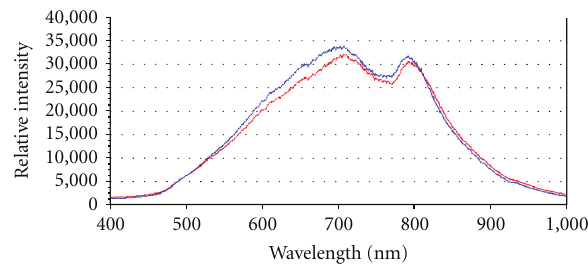
Figure 3: The light scattering curve as demonstrated by BWspec software analyses. Red color represented LSIL and blue represented